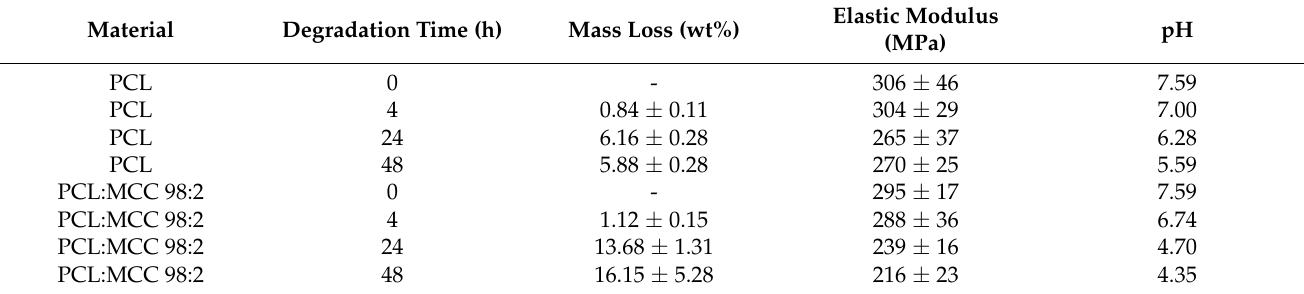
Table 1. Evolution of mass and elastic modulus with the enzymatic degradation time.